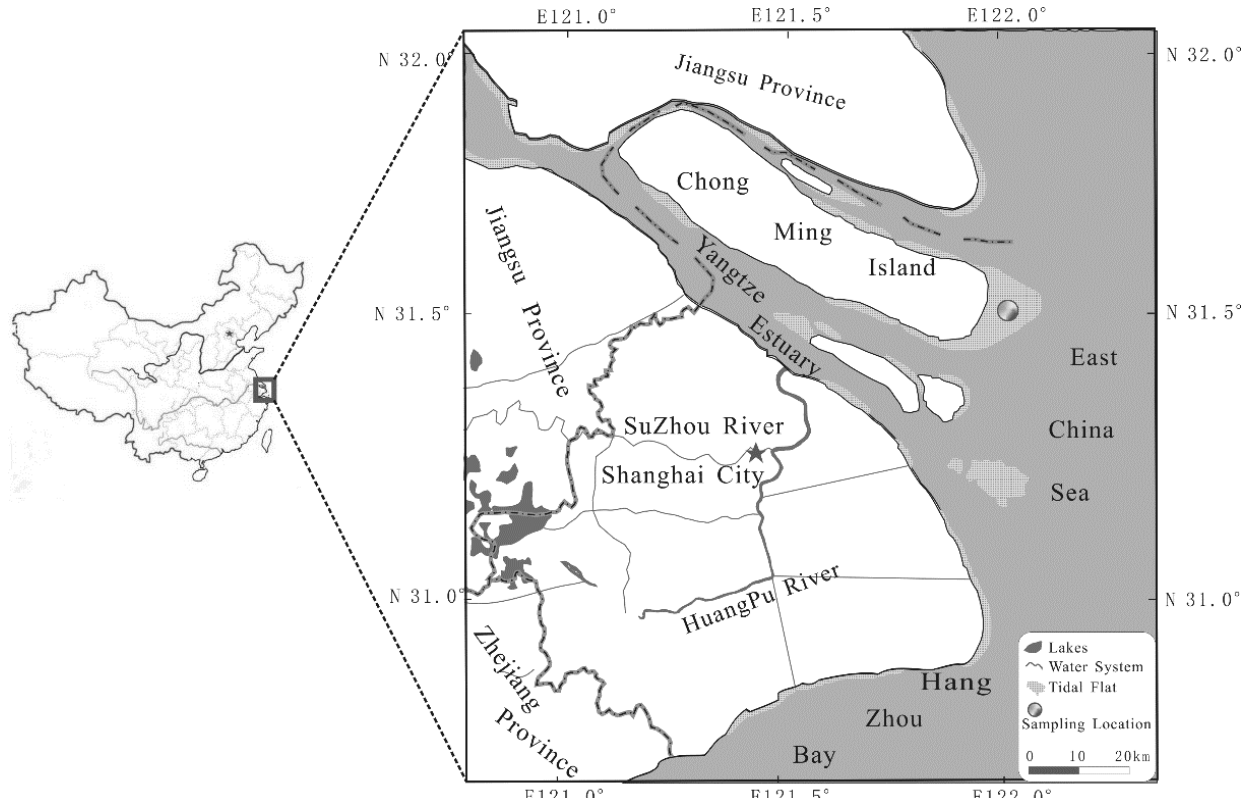
Figure 1. Study site in the salt marshes of the Yangtze estuary covered by the Scirpus mariqueter.